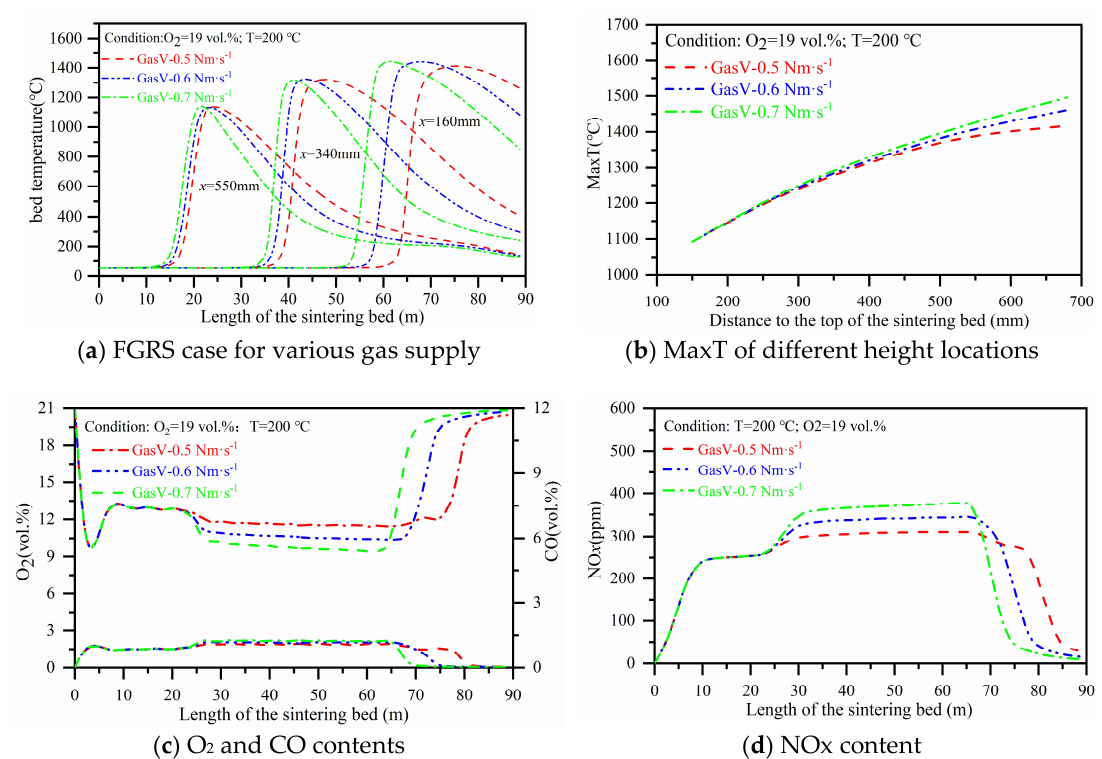
Figure 8. E ff ects of circulating gas supply on the NOx, CO, and O 2 contents in flue gas and layer